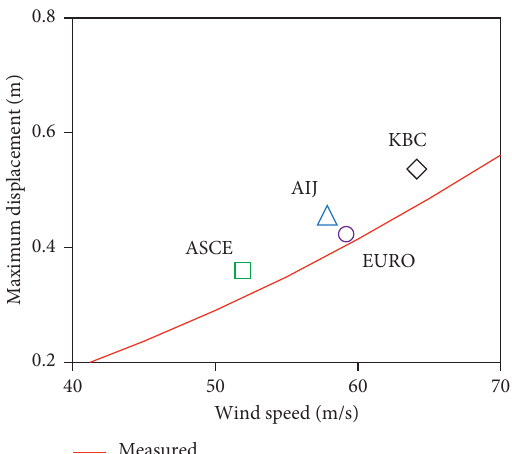
Figure 18: Maximum along-wind displacements by aeroelastic wind tunnel test and code-based structural